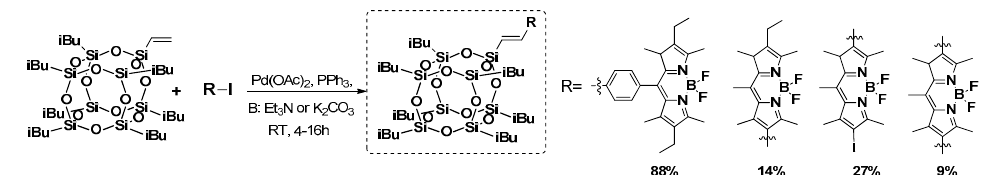
Figure 5. Respective structures for BODIPY derivatives of POSS.